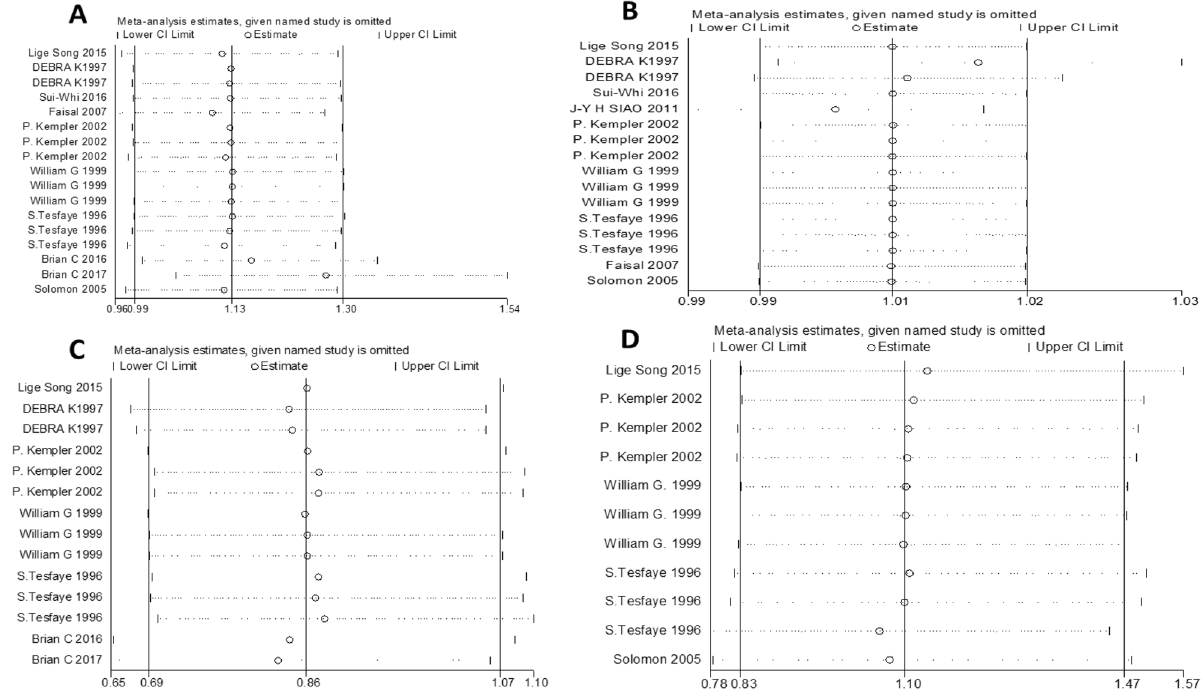
Figure 9. Sensitivity analysis of the pooled OR for ( A ) TG, ( B ) TC, ( C ) HDL, and ( D )